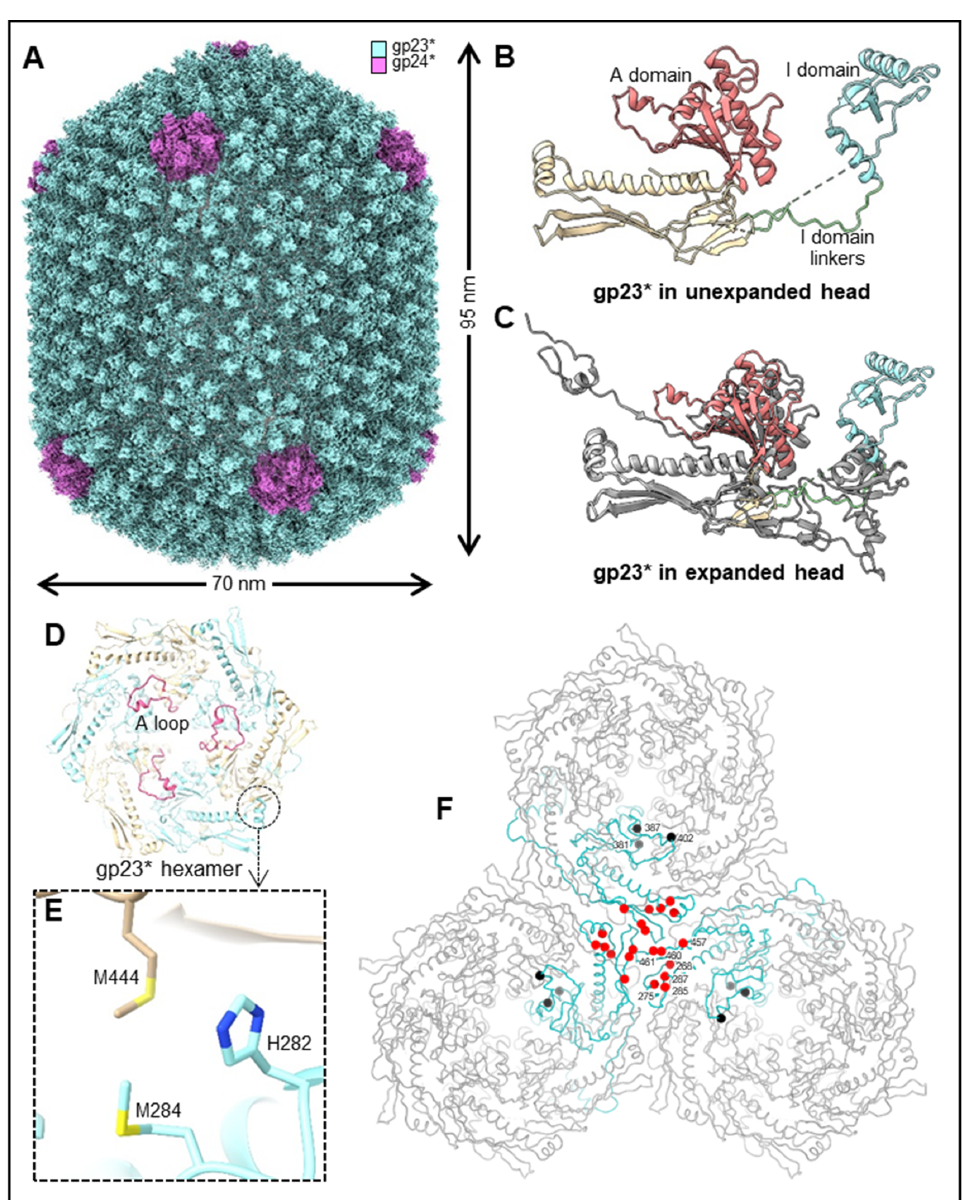
Figure 5. Structure of the phage T4 unexpanded head. ( A ) Cryo-EM structure of the phage T4 unexpanded head (EMD-32103). ( B , C ) Ribbon diagrams of gp23* in unexpanded (panel ( B )) and expanded (panel ( C )) conformations (PDB ID: 7VRT). ( D , E ) One portal vertex-surrounding capsomer ( D ) in the unexpanded head showing residues from two adjacent gp23* subunits forming a potential metal-binding cluster ( E ), whereas in the expanded head, the residues are from the same gp23*subunit (Figure 2). ( F ) Mutations involved in inter-capsomer interactions that alter the capsid length are clustered around the quasi-threefold axes (red dots), whereas the gp24 bypass mutations that do not alter capsid length affect intra-capsomer interactions (black